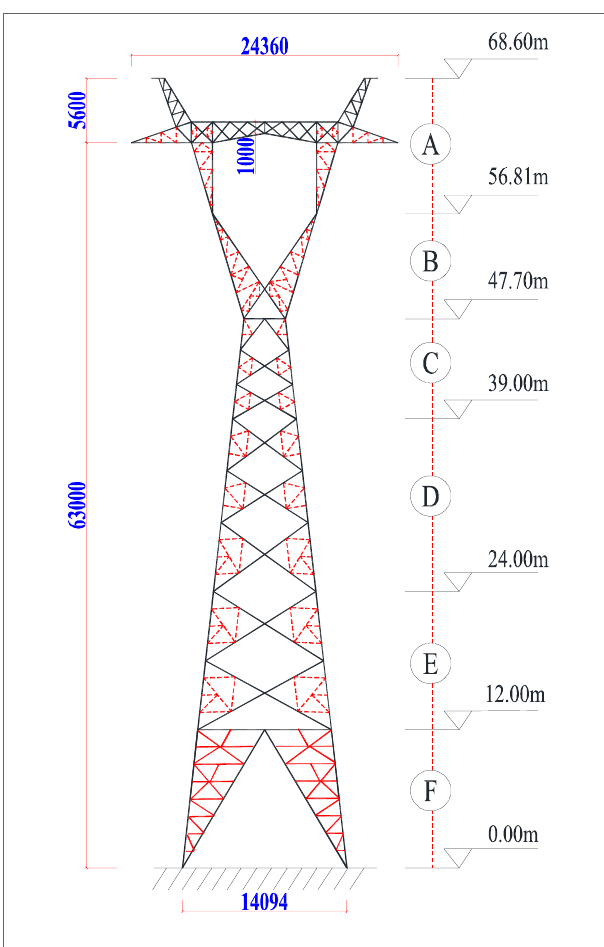
FigUre 1 | Model of the transmission tower